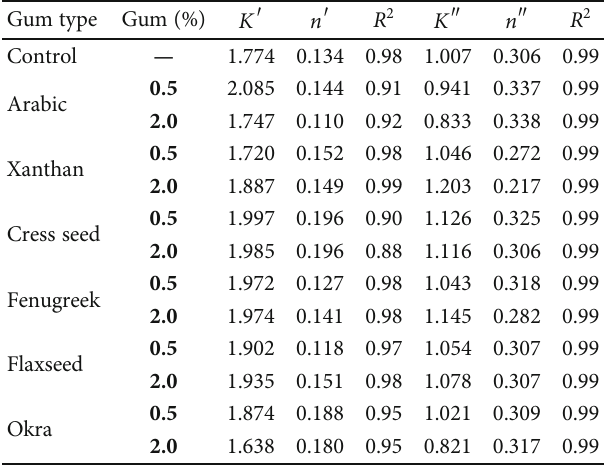
Table 2: E ff ect of gums on K ′ , K ″ , n ′ , and n ″ as determined from equations (1) and (2). Gum type Gum